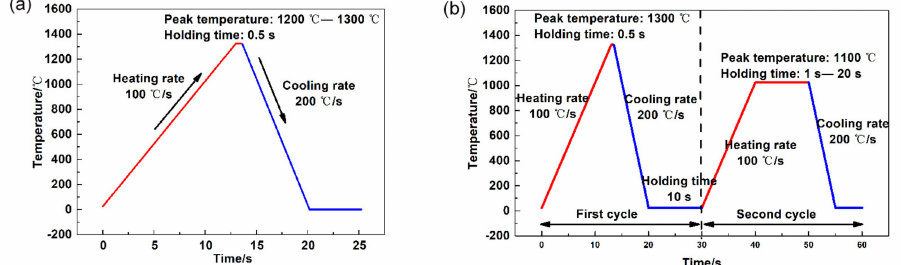
Figure 2. Temperature-time curves of thermal simulations: ( a ) one thermal cycle and ( b ) two thermal